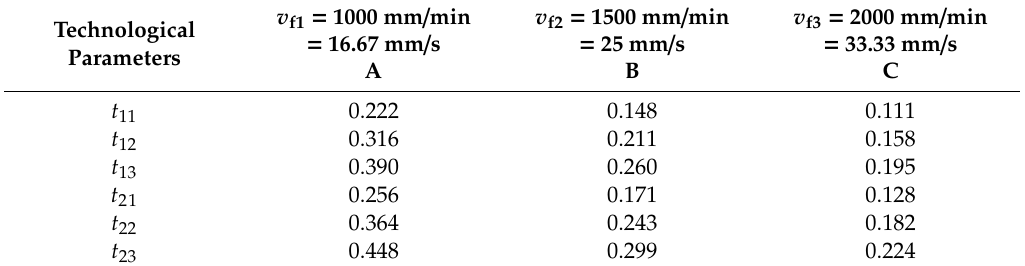
Table 3. The results for time obtained from Equation (3) expressed in seconds (s).